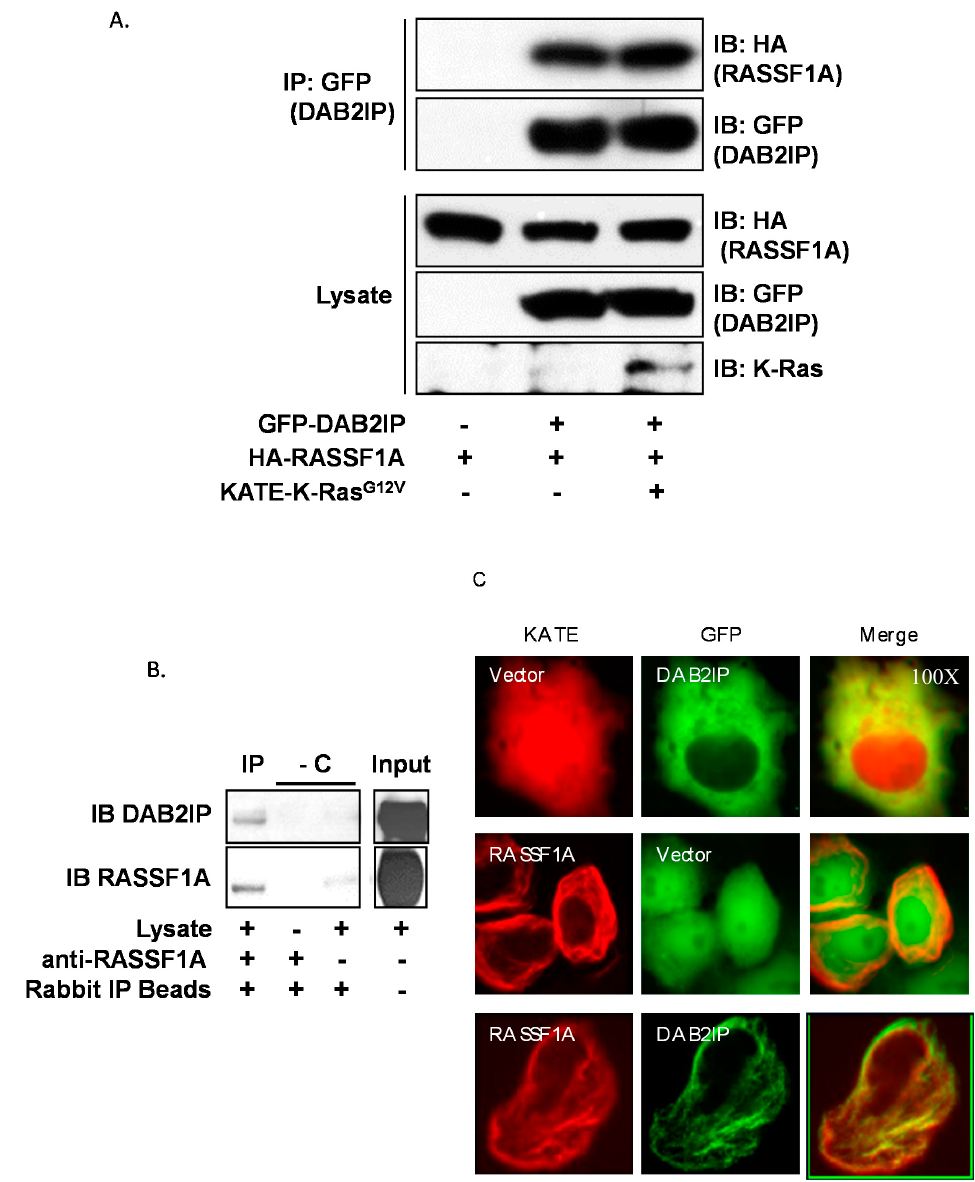
Figure 1. RASSF1A binds DAB2IP. IP = immunoprecipitation, IB = immunoblot, GFP = green fluorescent protein, HA = hemagglutinin, KATE = Katushka far-red fluorescent protein. ( A ) Co-immunoprecipitation of transiently overexpressed HA-RASSF1A with GFP-DAB2IP in HEK-293T cells in the presence or absence of activated K-RAS. Cells were plated and grown to 90% confluence, then transfected overnight. Cells were lysed in modified RIPA buffer. GFP was immunoprecipitated using antibody-conjugated beads and co-immunoprecipitation was detected via anti-HA Western blot. ( B ) Endogenous co-immunoprecipitation of DAB2IP with RASSF1A in un-transfected MCF10A breast epithelial cells. Two milligrams whole cell lysate prepared using modified RIPA buffer was incubated overnight with anti-RASSF1A antibody. Anti-RASSF1A was immunoprecipitated using anti-rabbit IP beads. Co-immunoprecipitation of DAB2IP was detected via anti-DAB2IP Western blot. Two IP reactions, one excluding the lysate and one excluding the anti-RASSF1A IP antibody, served as negative controls. -C = negative controls. ( C ) Fluorescence microscopy showing co-localization of transiently expressed GFP-DAB2IP with KATE-RASSF1A in COS-7 cells (100x). Cells were plated at low density on glass-bottom dishes and transfected overnight. Images were acquired on an inverted microscope under oil